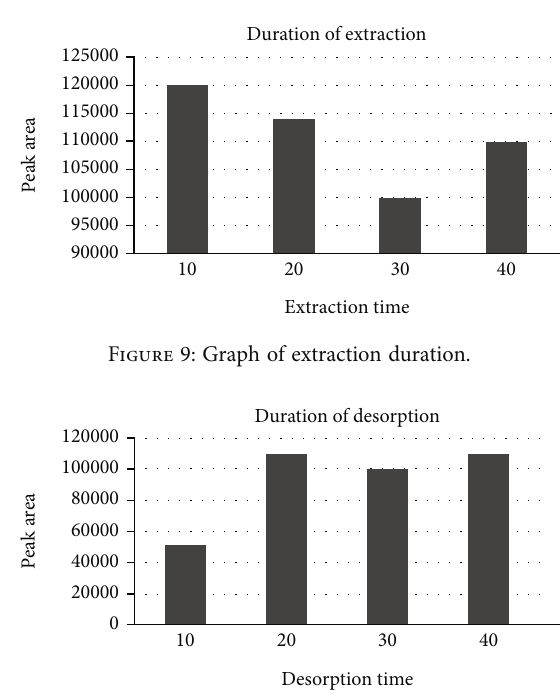
Figure 12: Analyzing NGPCC reusability.